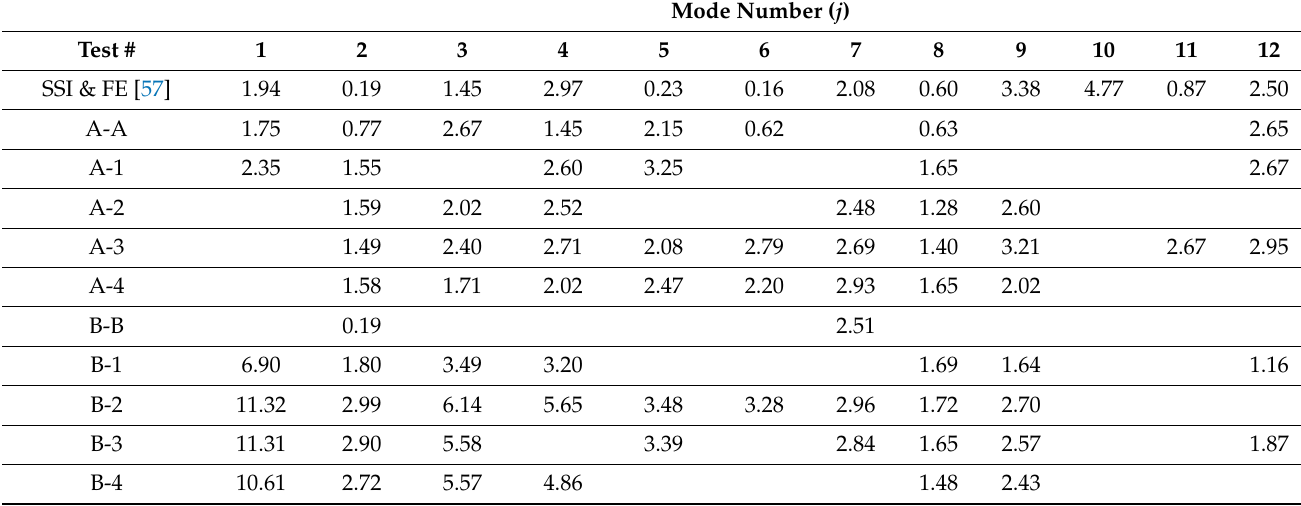
Table 5. Estimated damping ratios (%) of the Eeklo Pedestrian Bridge corresponding to the identified modal frequencies using